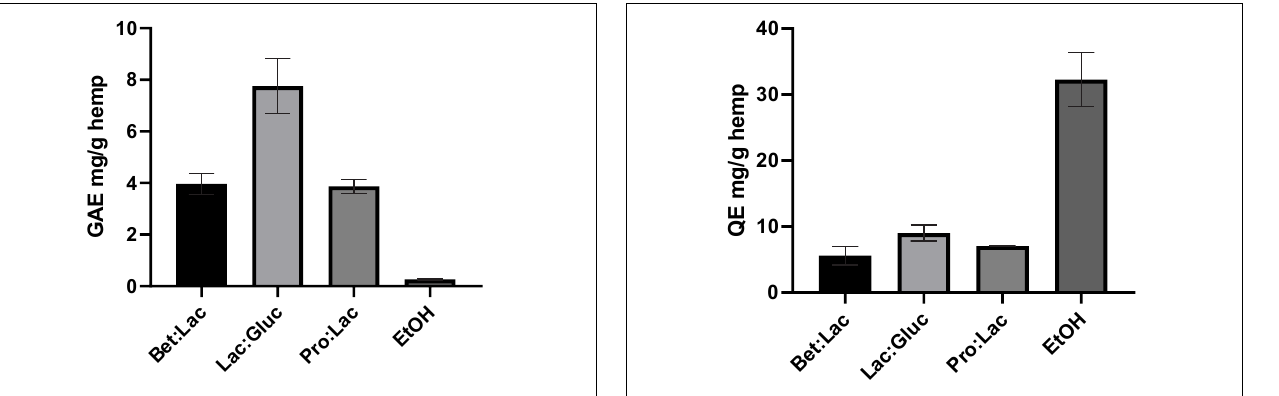
FIGURE 4 | Total flavonoid content related to the different solvents tested and expressed in mg QE/g hemp (extraction conditions: 60 ◦ C, 90 min, and a 1:10 S/L